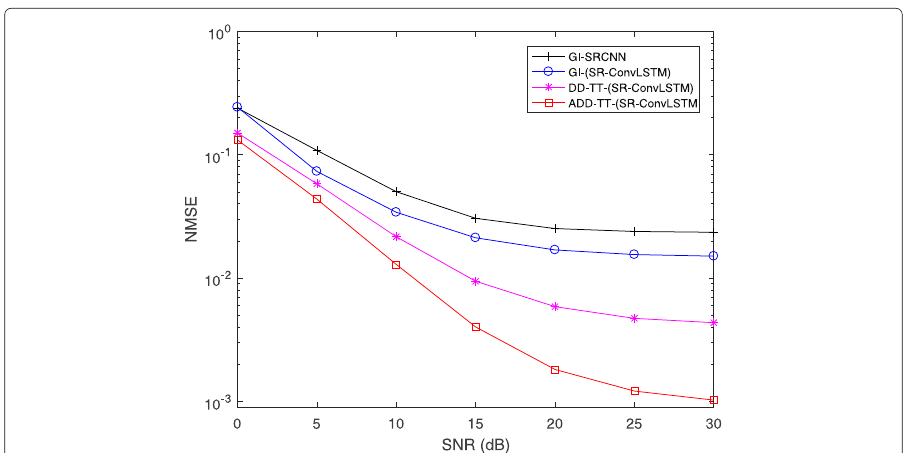
Fig. 6 NMSE for ablation analysis with 4QAM modulation, maximum Doppler = 1200 Hz and 60 OFDM symbols (VTV Expressway